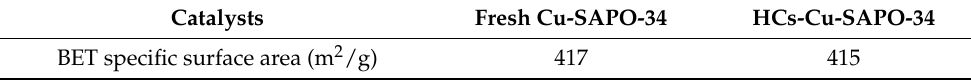
Table 1. Comparison of BET surface area results of fresh Cu-SAPO-34 and HCs-Cu-SAPO-34. Catalysts